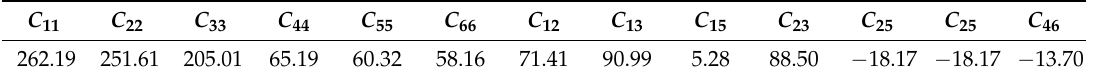
Table 4. Elastic constants (in GPa) of monazite-type GdPO 4 at 0 GPa.